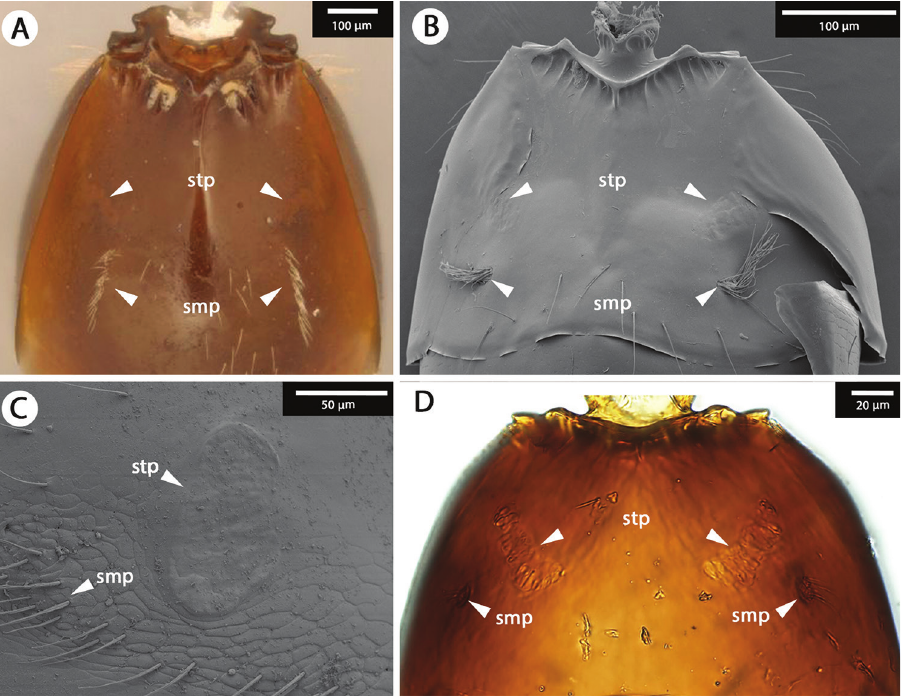
Figure 3. Images of the synsternal translucent and setiferous patches in the metasoma of different Cer- aphronoidea. A Brightfield image of a Ceraphron sp. (Hymenoptera: Ceraphronidae) (identifier: PSUC_FEM 27234) B SEM image of Masner lubomirus Deans & Mikó, 2015 (Hymenoptera: Ceraphronidae) (identifier: PSUC_FEM 470955) C SEM image of Trichosteresis glabra Boheman, 1832 (Hymenoptera: Megaspilidae) (identifier: IM 1512) D Brightfield image of a Trassedia sp. (Hymenoptera: Ceraphronidae) (identifier: IM 1109/ NCSU 71196) Abbreviations: smp = synsternal setiferous patch; stp = synsternal translucent